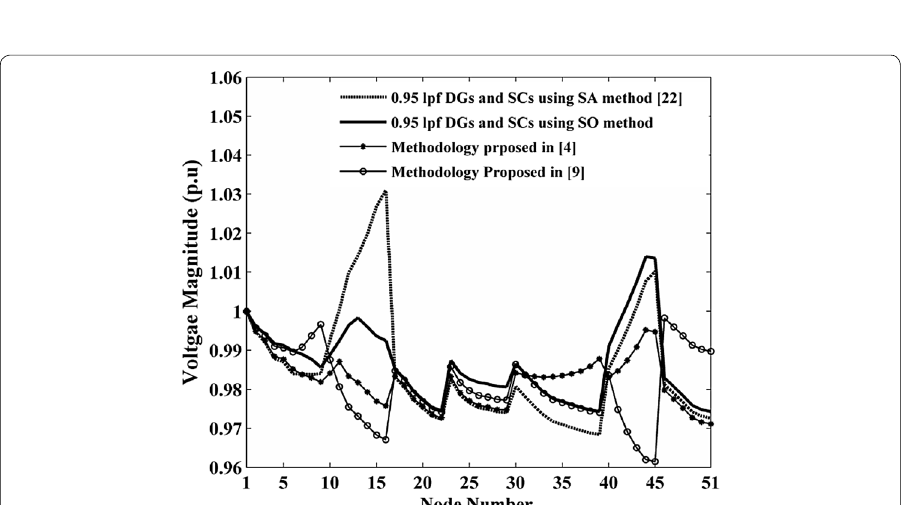
Fig. 8 Voltage profile comparison with methods [4] and [9] for 51-node